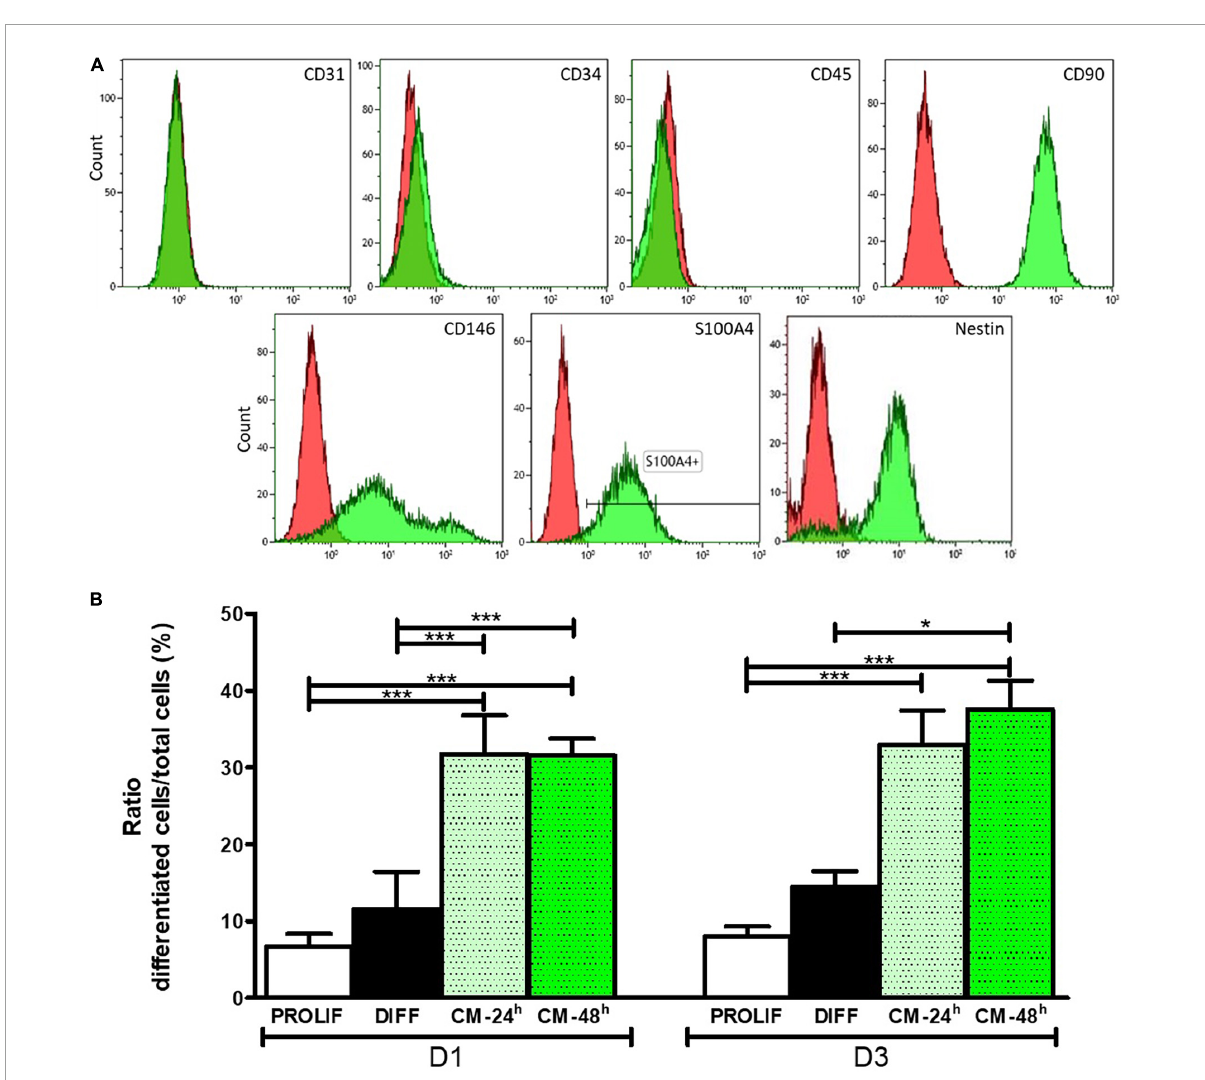
FIGURE4 The olfactory stem cells: phenotypic characterization (A) and effect of OE-MSC-conditioned media on neuronal differentiation (B) . (A) Flow cytometry indicates that purified cells are negative for the usual markers of hematopoietic stem cells (CD31, CD34, CD45) and positive for the recognized markers of olfactory ecto-mesenchymal stem cells (CD90, CD146, S100A4, NESTIN). Green: cells stained with the pre-prepared antibodies; red: cells stained with isotype controls. (B) The percentage of differentiated N2a is significantly increased at day 1 and 3,